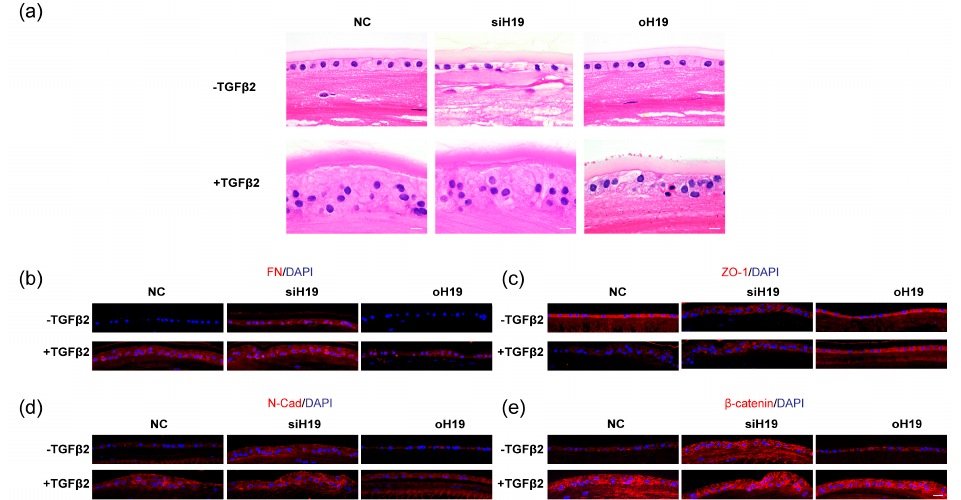
lens clarity. Scale bar, 200 µ m. ( b ) Hematoxylin and Eosin (HE) staining of the mouse whole lens explants was collected after being cultured for 6 days. Scale bars, 10 µ m. ( c ) Immunofluorescent staining of FN, α -SMA, N-Cad, and ZO-1 in freshly cut sections of the mouse whole lens explants was also collected on day 6 of culturing. Scale bars, 20 µ m.